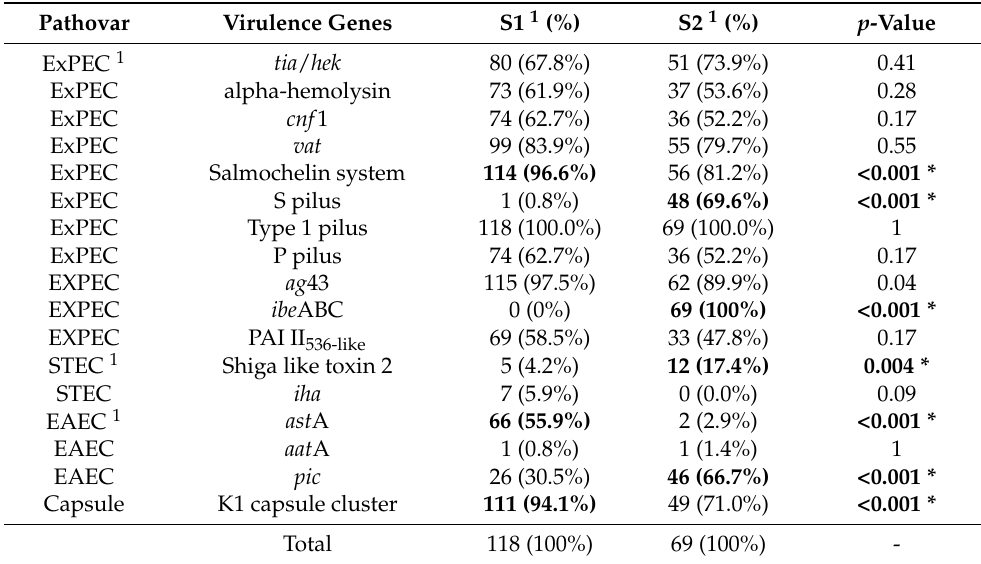
Table 2. Virulence genes and lineage distribution of E. coli ST141